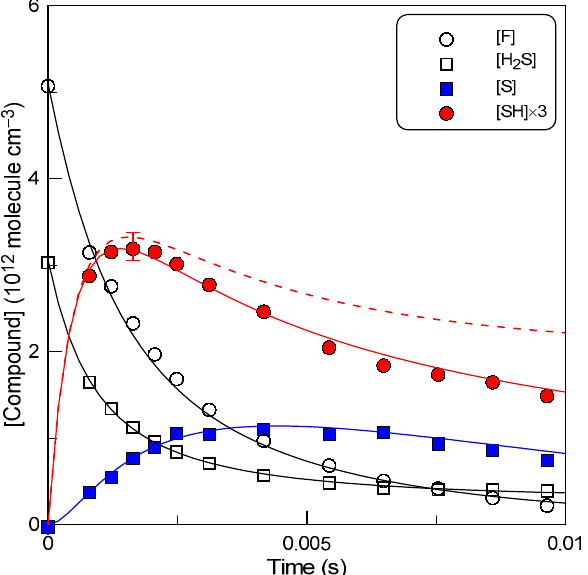
Figure 5. Reaction F + H 2 S: measured (points) and simulated (lines) kinetics of the reactants (F and H 2 S) and products (S and SH), T = 295 K.